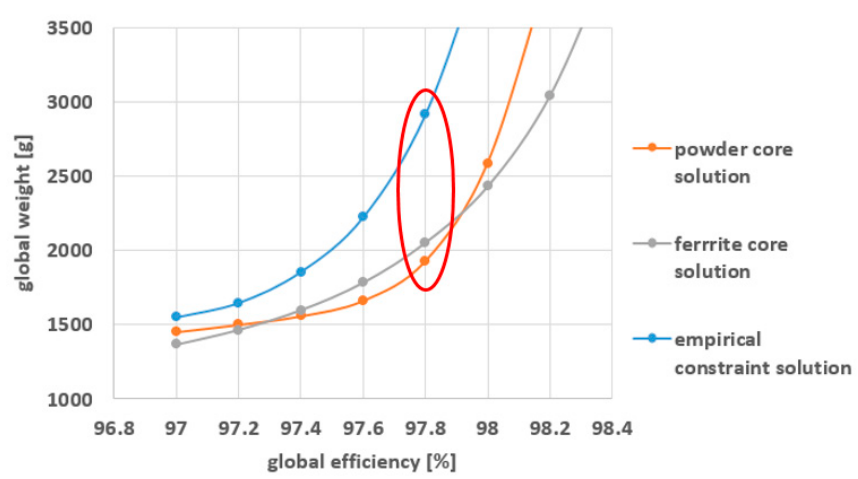
Figure 9. Pareto front weight efficiency: the three encircled points are discussed in the text.